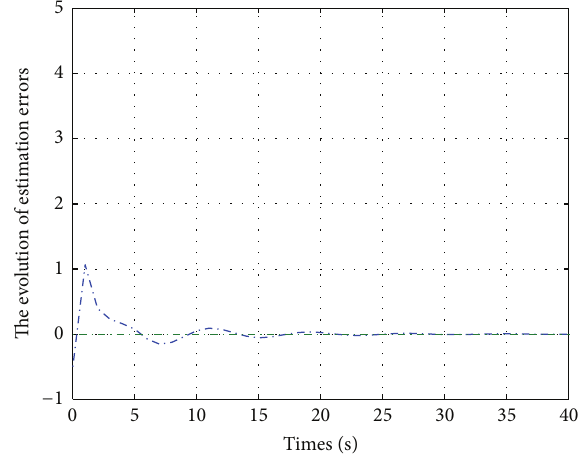
Figure 3: The evolution of estimation errors 𝑒(𝑘) .